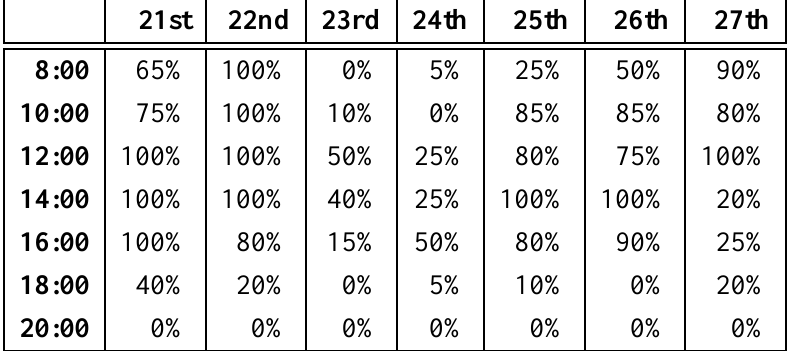
Table 3. Percentages of sunshine period for every two hours during August 21–27,